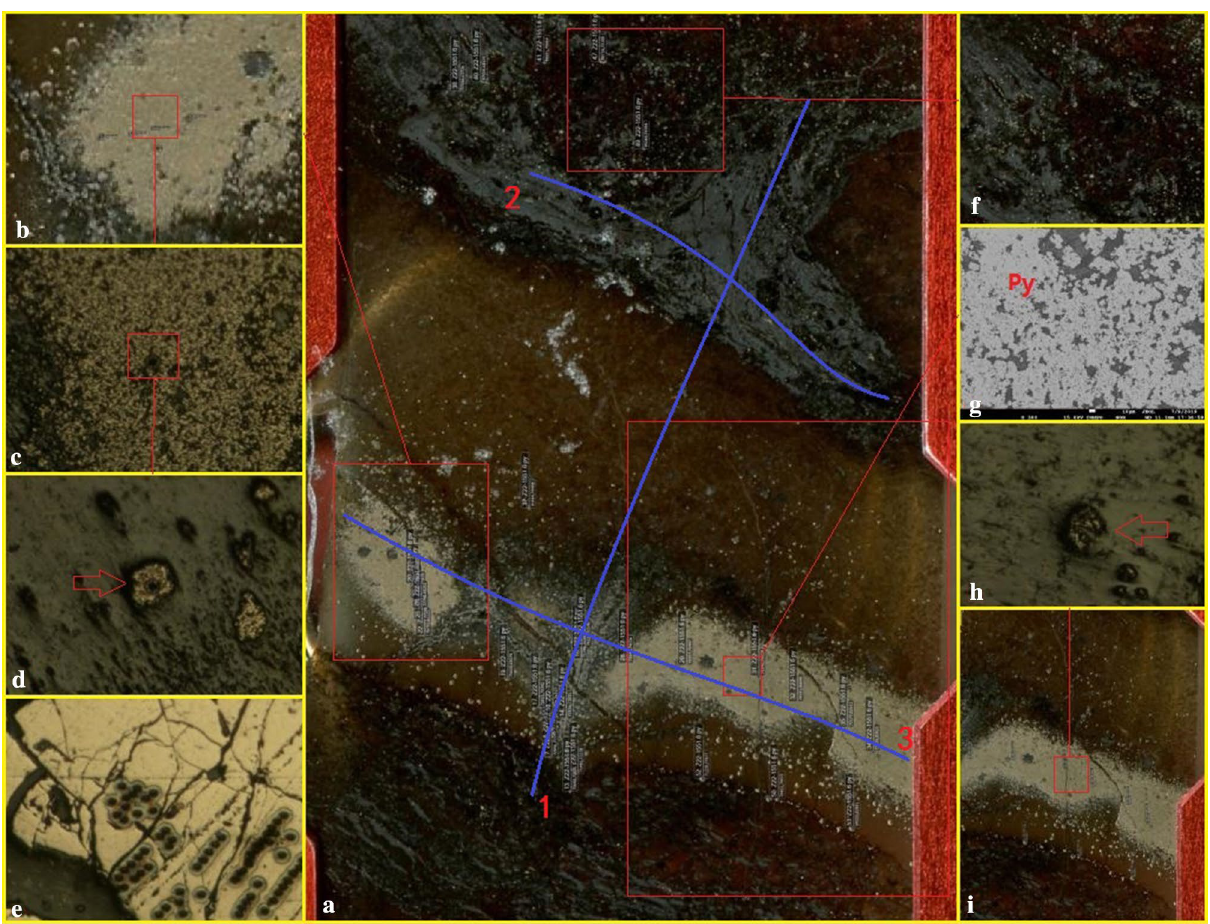
Figure 5. Analytical points for in situ trace elements and sulfur isotopes around pyrite in the hydrothermal chimney. ( a ) Macroscopic photograph of the hydrothermal vent and experimental point, where the three blue lines indicate the positions of the in situ trace elements. ( b ) Partially enlarged photograph of panel ( a ). ( c ) Partially enlarged photograph of panel ( b ). ( d ) Partially enlarged photograph of panel ( c ). ( e ) Standard